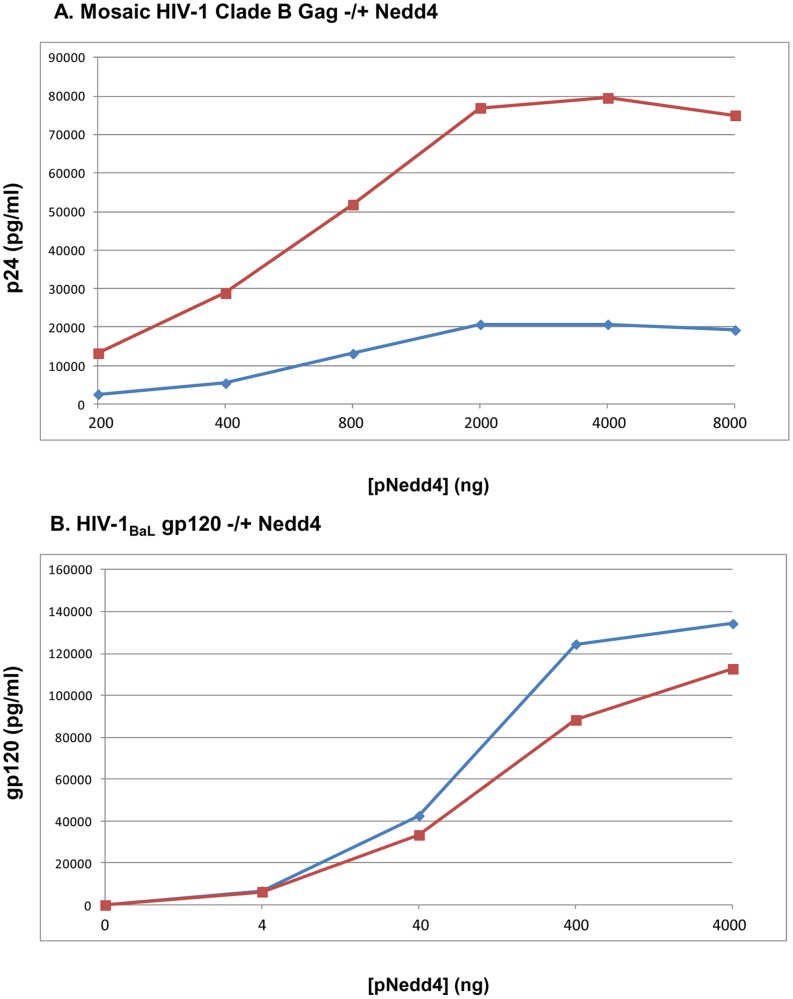
Increased Levels of Extracellular and Intracellular p24 Gag and gp120 Env Proteins by Nedd4.293 cells were transiently transfected with a plasmid DNA expressing a clade B Mosaic Gag (A) or HIV-1BaL gp120 (B) and increasing concentrations of hNedd4 as described (Materials and Methods). At 48 hr post-transfection, cell supernatants or cell lysates were assayed for p24 (A) or gp120 (B) by ELISA. Levels (pg/ml) of p24 (A) and gp120 (B) are represented graphically for supernatants (blue line) or cell lysates (red line).